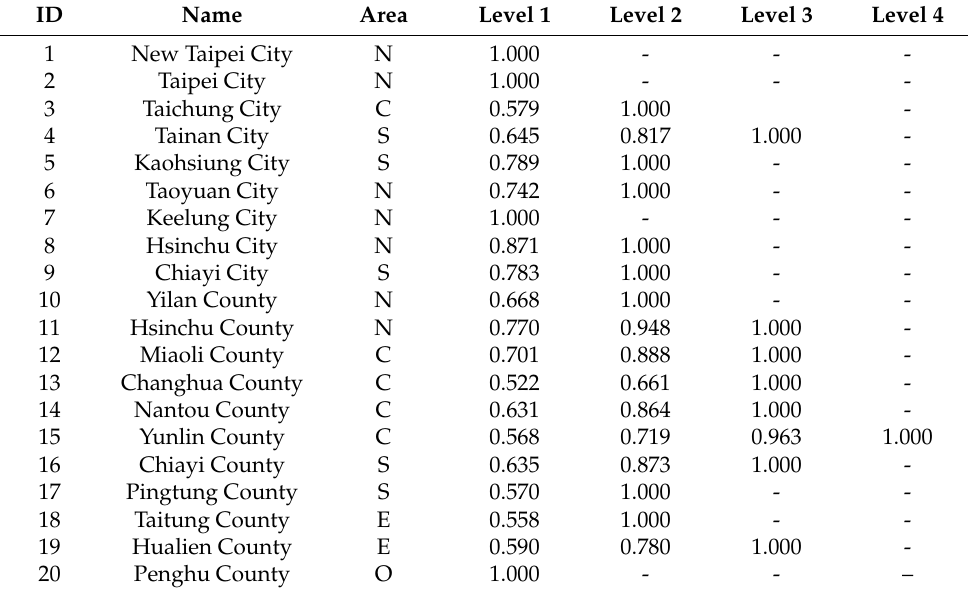
Table 5. Multi-level efficiency frontiers of electricity for lighting of cities and counties in Taiwan.